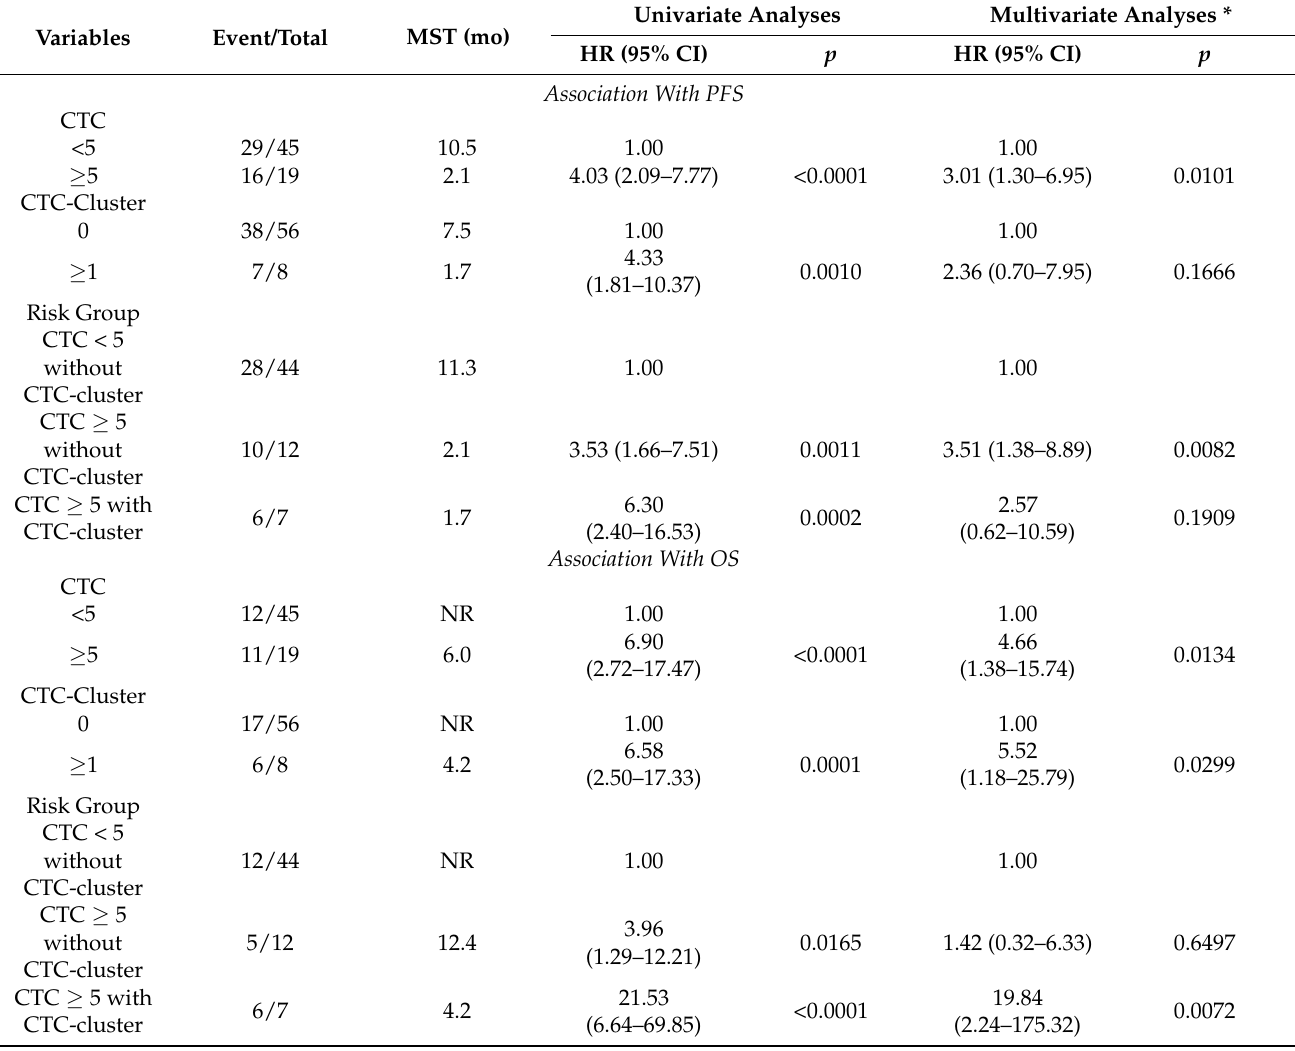
Figure 1. Kaplan-Meier estimates of the probability of progression-free survival (PFS) and overall survival (OS) in metastatic castration-resistant prostate cancer (mCRPC). Survival differences were compared between patients with <5 circulating tumor cells (CTCs) and ≥ 5 CTCs (( A ) for PFS and ( B ) for OS), or between those with 0 and ≥ 1 CTC-clusters (( C ) for PFS and ( D ) for OS). Table 2. Associations of baseline CTC and CTC-cluster with clinical outcomes.